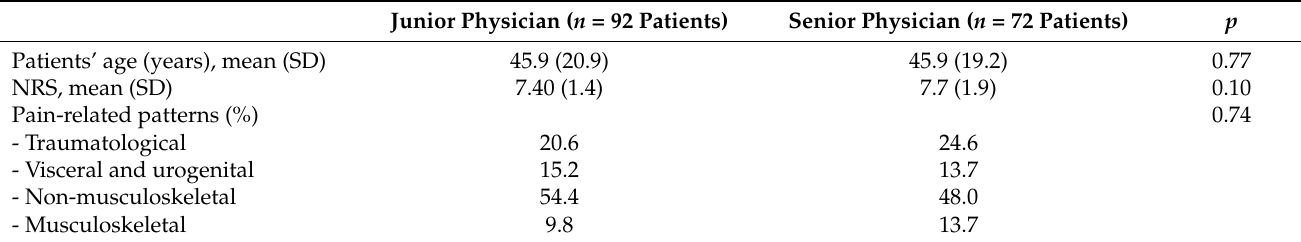
Table 1. Characteristics of patients in the “real” condition of prescription according to physician grade ( n = 164). Junior Physician ( n = 92